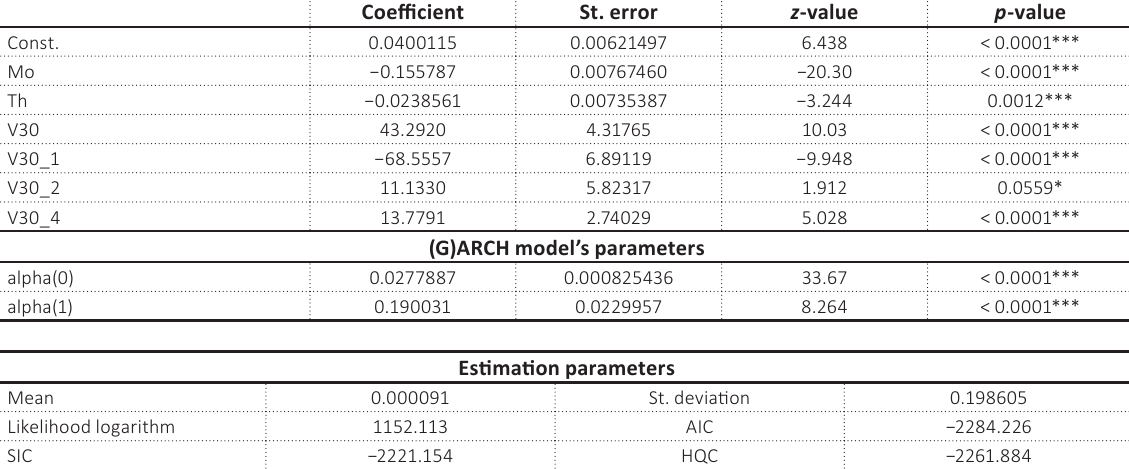
Table 3. ARCH(1) estimation for NIKKEI 225 index